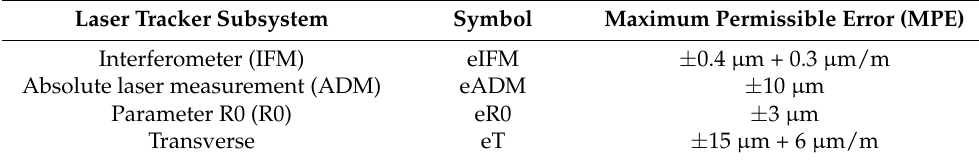
Table 1. The maximum permissible error of the